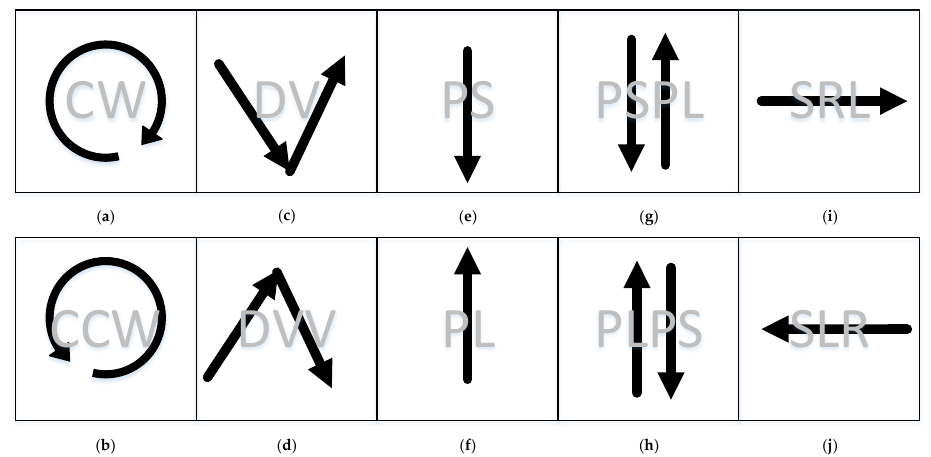
Figure 10. Gestures considered in the experiments. ( a ) CW: Clockwise; ( b ) CCW: Counter Clockwise; ( c ) DV: Drawing V; ( d ) DVV: Drawing verse V; ( e ) PS: Push; ( f ) PL: Pull; ( g ) PSPL: Push and Pull; ( h ) PLPS: Pull and Push; ( i ) SRL: Sliding Right to Left; and, ( j ) SLR: Sliding Left to Right.